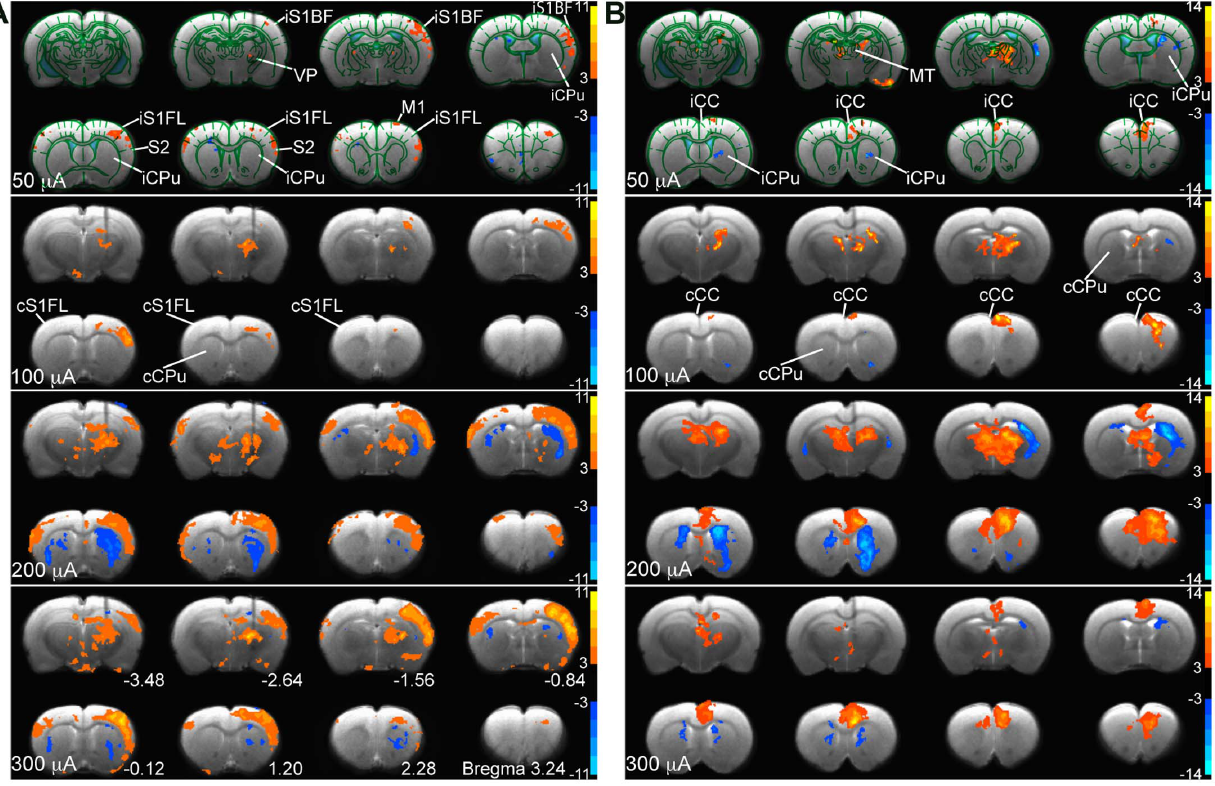
Figure 3. Intensity-dependent activity maps and region of interest analysis in the brain during VP and MT stimulation. The group activation maps elicited by VP (3 Hz, n=4) and MT (9 Hz, n=6) stimulation at four intensities level (from top to bottom, 50, 100, 200 and 300 m A) shown on eight coronal sections of the forebrain in two rows. (A) With VP stimulation, positive BOLD responses (warm color) were activated most strongly in the iS1FL and iS1BF, and negative BOLD responses (cold color) in the iCPu and cCPu. (B) With MT stimulation, positive BOLD responses were activated most strongly in the iCC, and most negative responses were found in the iCPu. Demarcations of region of interest (ROI) are outlined in the top panel of the